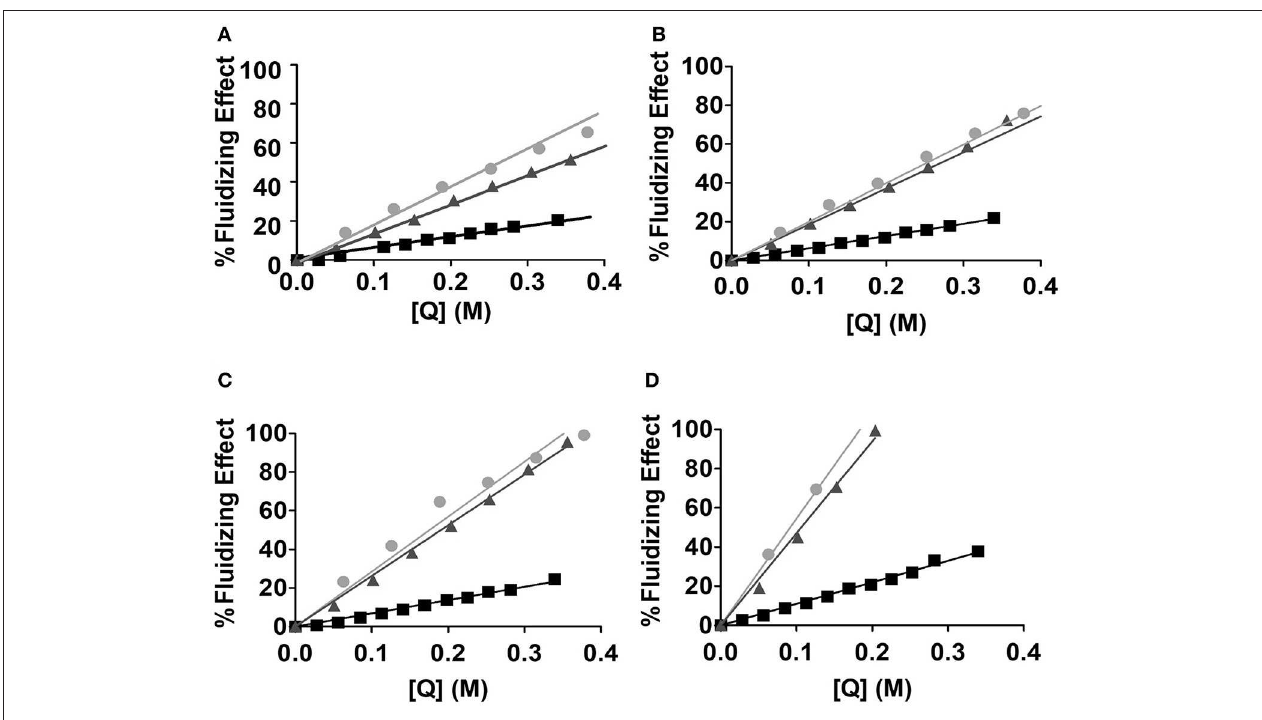
FIGURE 8 | Fluidizing effect (%) caused by increasing concentrations of quenchers [Q]: Tolmetin ( (cid:4) ), Acemethacin and ( ) and Indomethacin ( ), in MLVs of EPC (500 µ M, in Hepes buffer pH = 7.4 and I = 0.1M) labeled with n -AS probes: (A) 2-AS; (B) 6-AS; (C) 9-AS and (D) 12-AS.